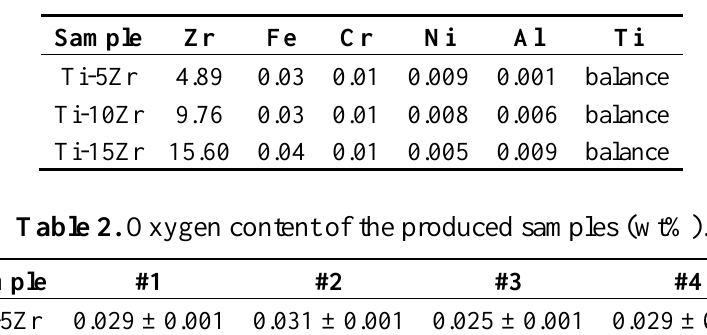
Table 1. Chemical composition (in wt%) of the Ti-Zr produced alloys.